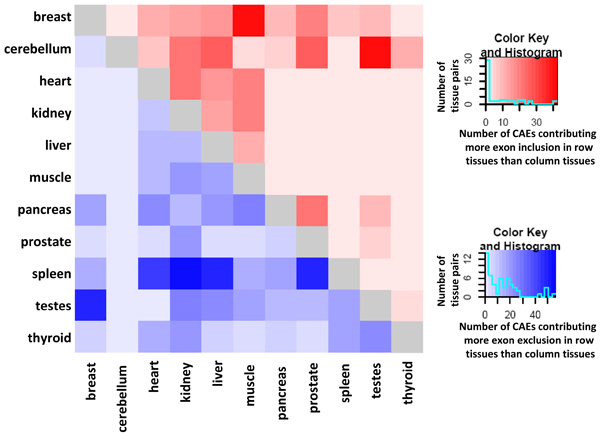
Heatmap of predicted cis-acting RNA elements (CAEs) contributing more exon inclusion/exlusion to row tissues than column tissues. For each pair of row tissue and column tissue, each unit in upper right (red colored)/lower left diagonal (blue colored) stands for the number of predicted CAEs contributing more exon inclusion/exclusion to row tissue than column tissue. Darker red and blue colors indicate larger number of predicted elements respectively.